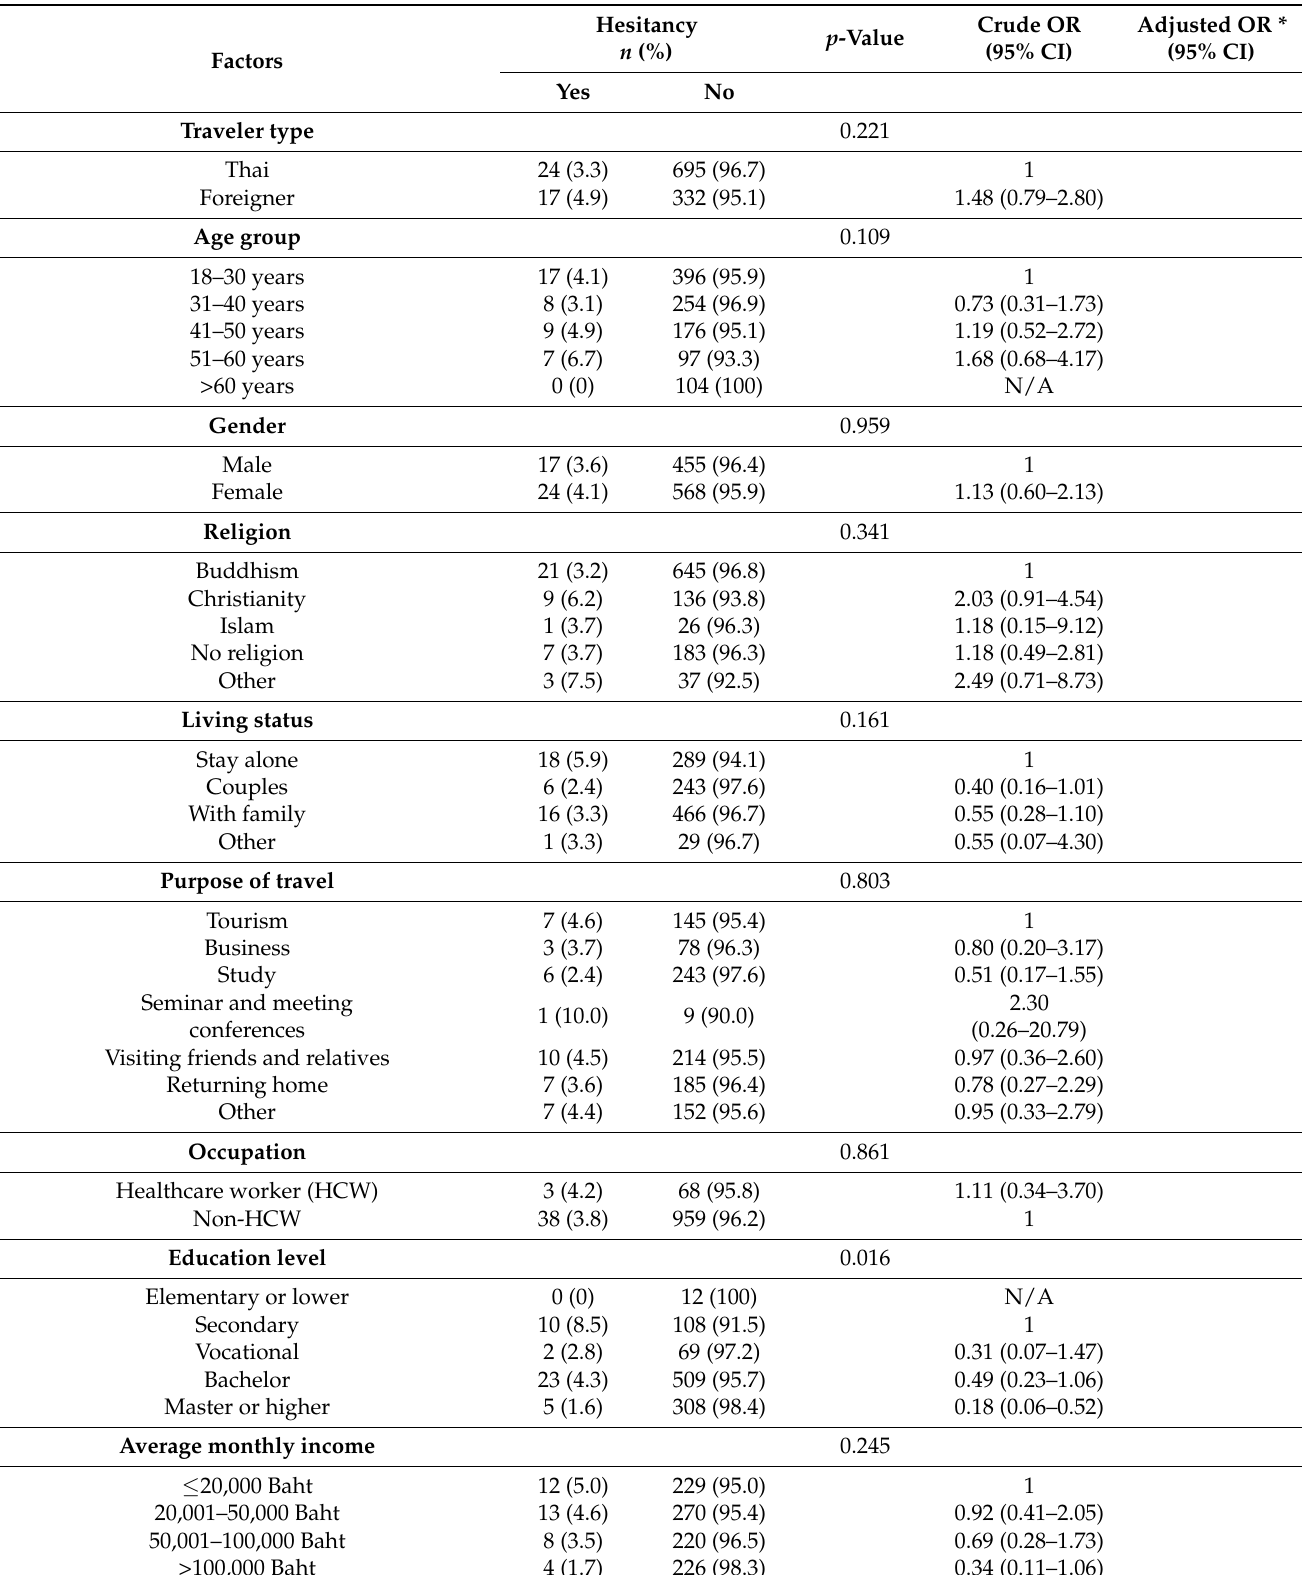
Table 2. Factors associated the vaccine